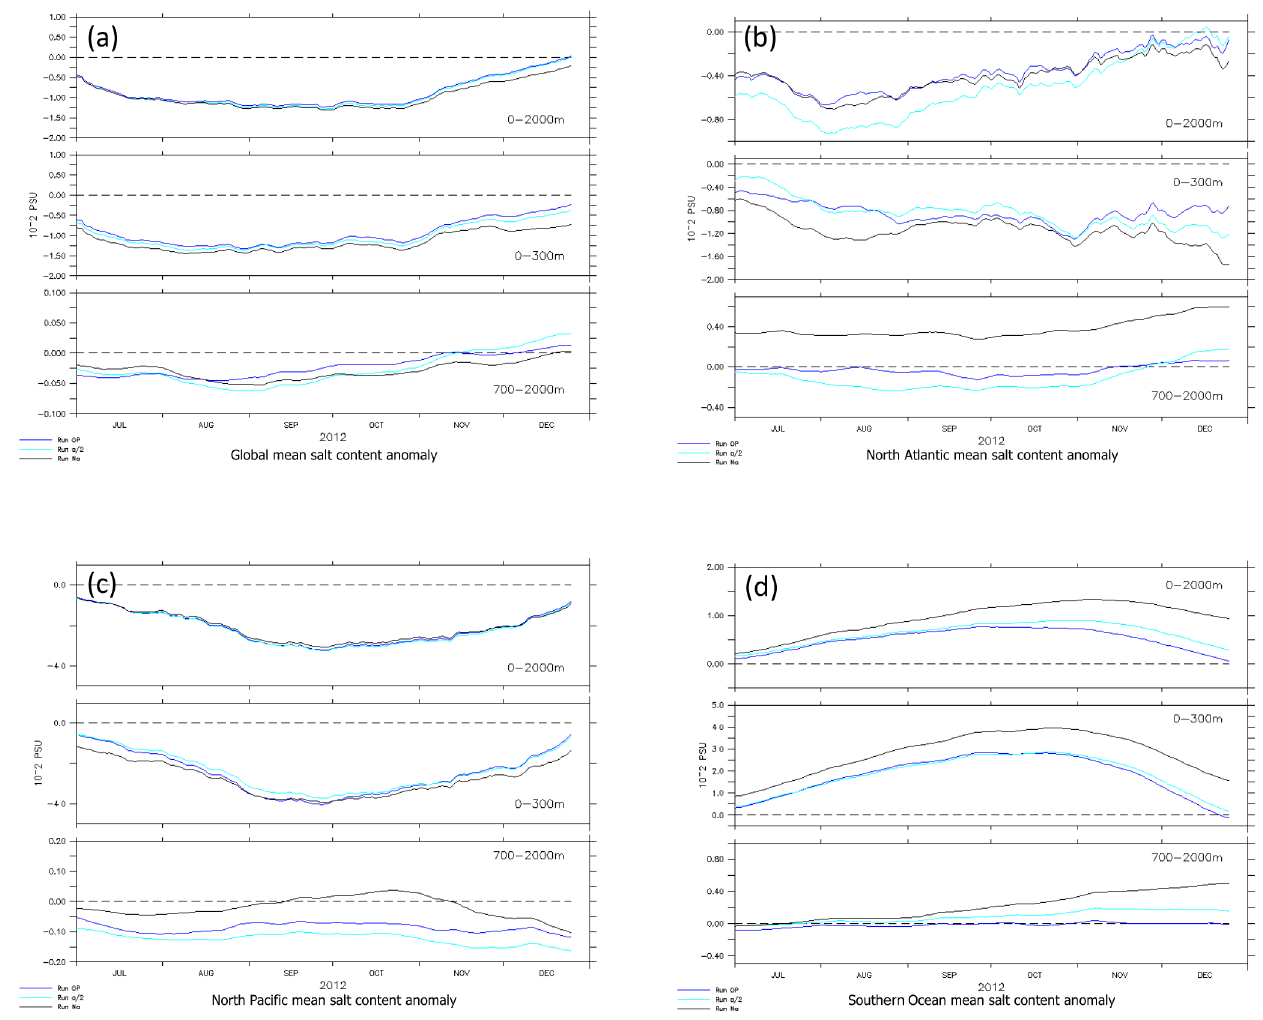
Figure 12. Salt content anomaly time series for the 0–2000, 0–300 and 700–2000m layers from Run-Ref (blue), Run-NoArgo (black), and Run-Argo2 (light blue) and for the global ocean (a) , North Atlantic (b) , North Pacific (c) , and Southern Ocean (d)